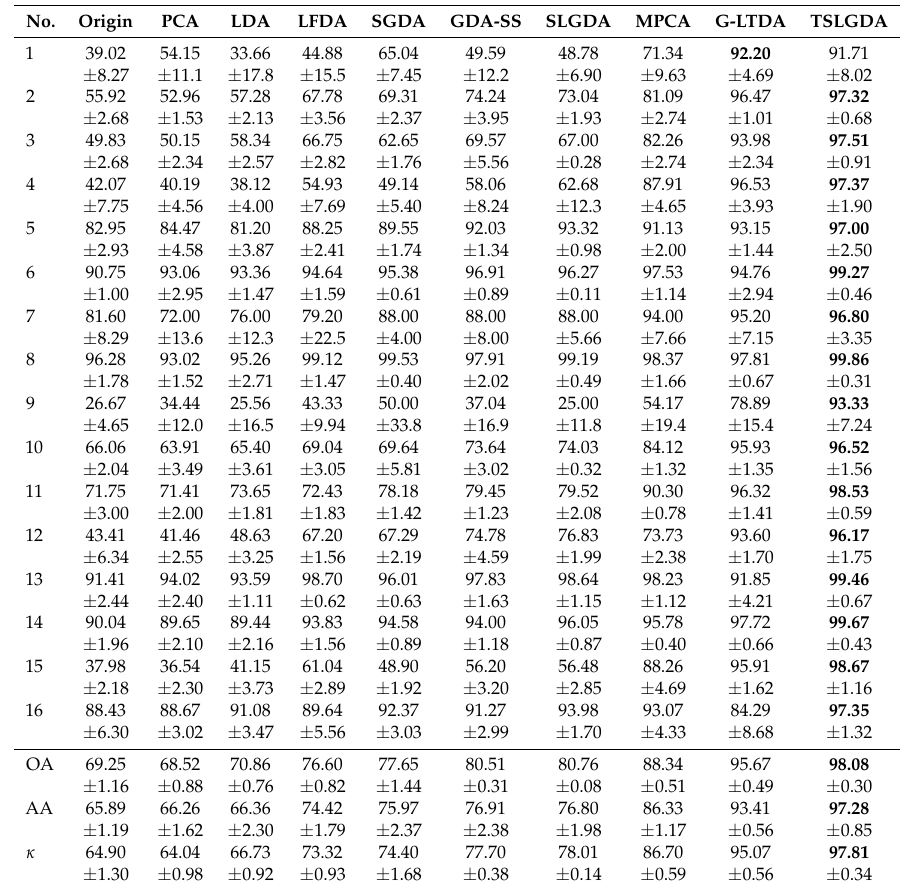
Table 3. Classification accuracy (%) and standard deviation of different methods for the Indian Pines data when the reduced dimension is 30.